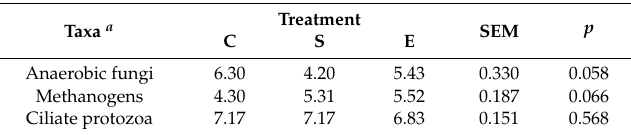
Table 2. Anaerobic fungi, methanogens and ciliate protozoa in the rumen of goats fed di ff erent feed types of mulberry leaves.